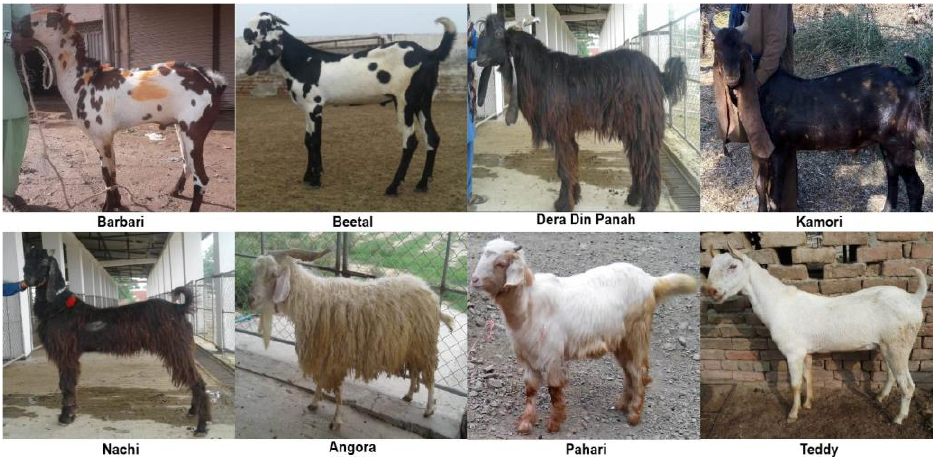
Figure 1. Representative animals of eight Pakistani goat breeds.